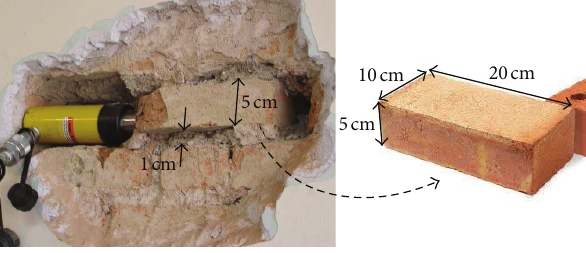
Figure 5: Mortar shear stress test on the infill panel.